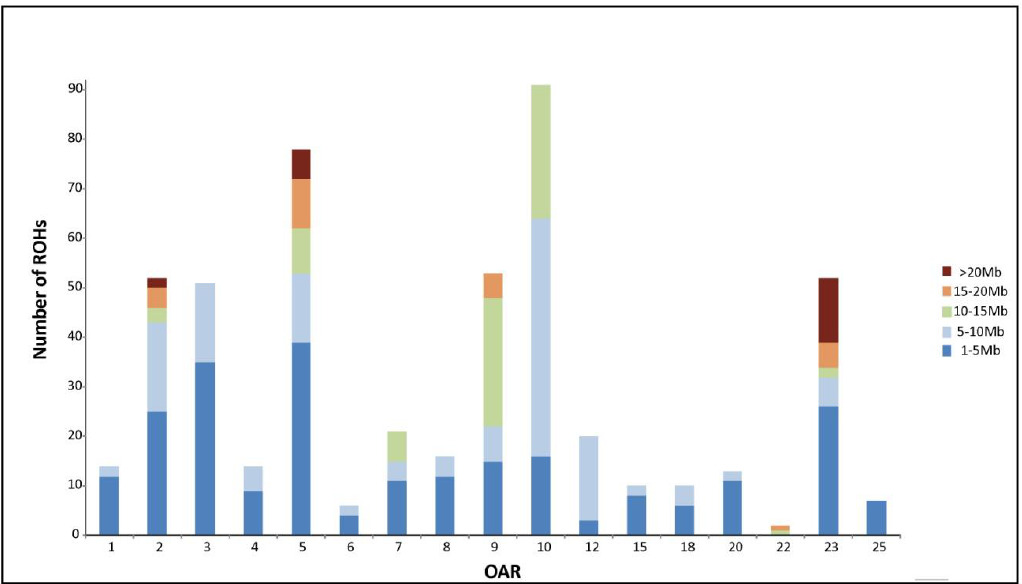
Figure 3. Runs of homozygosity distribution and coverage for each autosome in Djallonké sheep. The barplot shows the number of runs of homozygosity in different length classes: 1–5 Mb, 5–10 Mb, 10–15 Mb, 15–20 Mb, and >20 Mb.